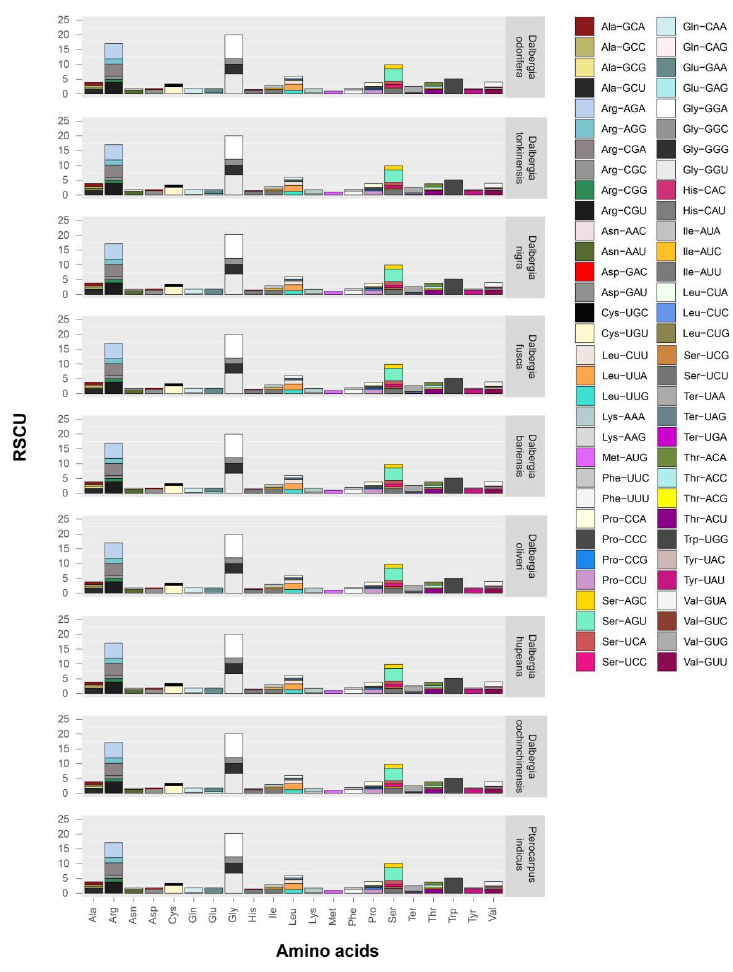
Figure 8. Codon content of 21 amino acids and a stop codon of 77 coding genes from 8 newly assembled Dalbergia chloroplast genomes. Color of the histogram corresponds to the color of codons in legend.